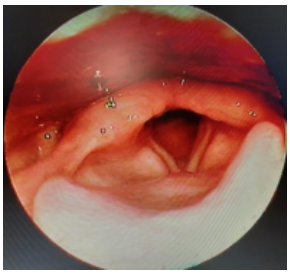
Figure 11. Acute laryngitis